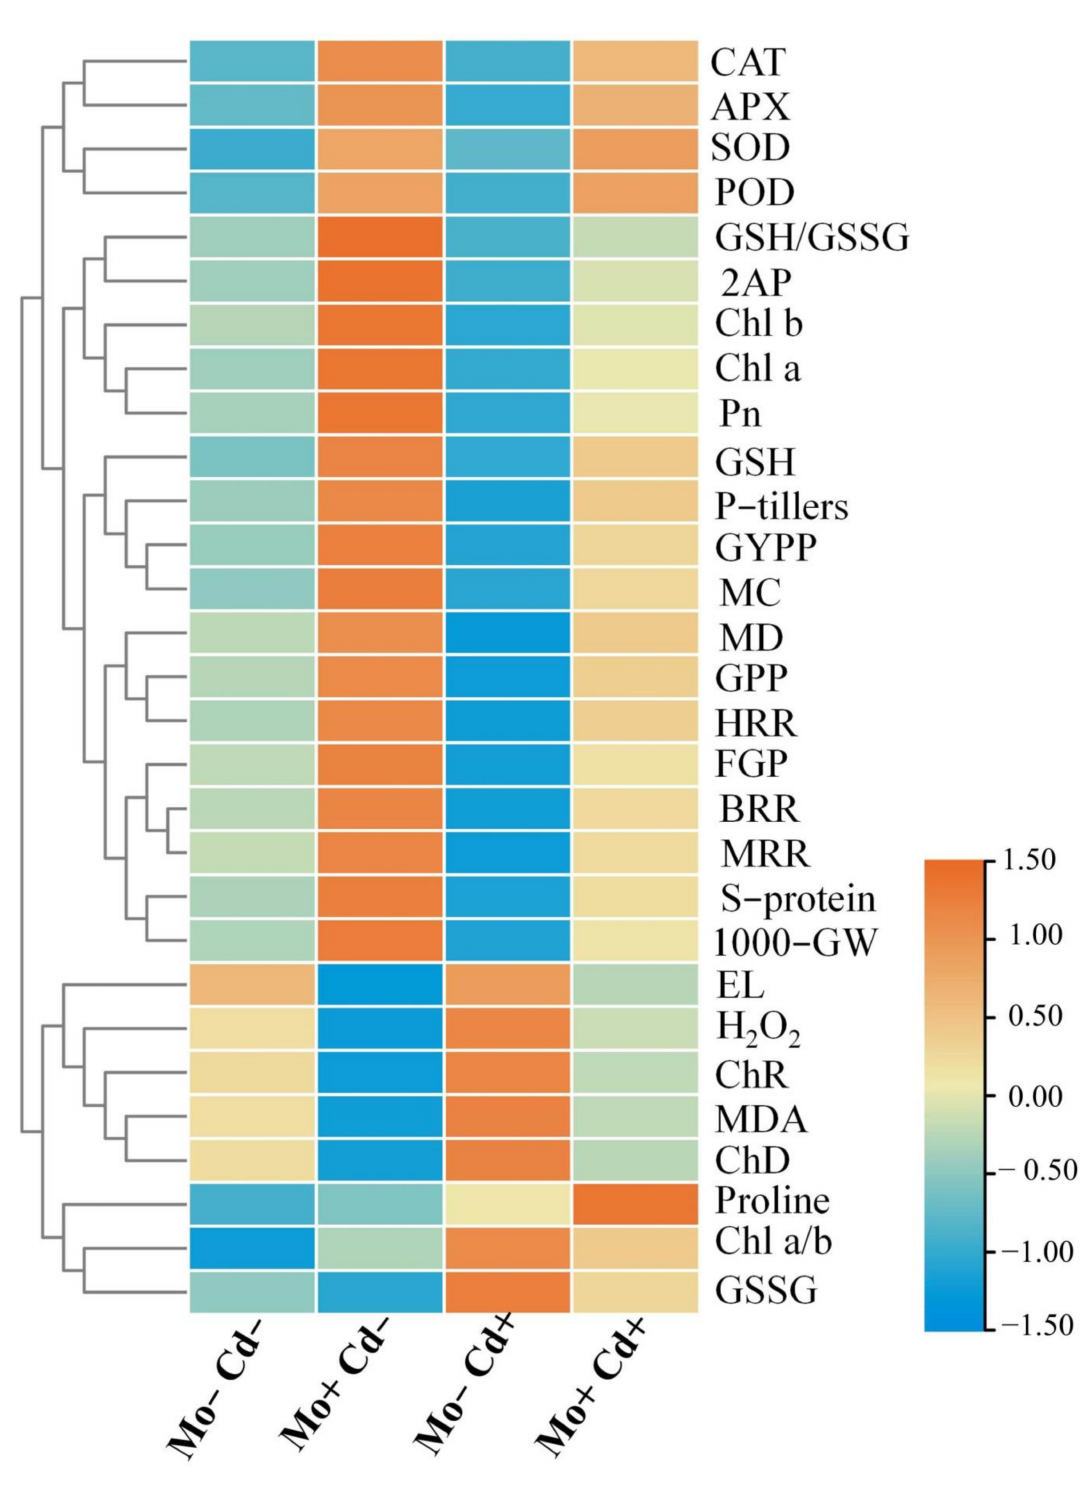
Figure 8. Heat-map reveals a hierarchical clustering analysis between different treatments and studied parameters of aromatic rice plants. Abbreviated names are as follows: 2AP (2-acetyl-1-pyrroline), SOD (superoxide dismutase activity), POD (peroxide activity), CAT (catalase activity), APX (ascorbate peroxidase activity), Chl a (chlorophyll a), Chl b (chlorophyll b), Pn (photosynthetic rate), GSH (reduced glutathione), GSSG (oxidized glutathione), P-tillers (productive tillers), HRR (head rice rate), MRR (milled rice rate), FGP (filled grain percentage), BRR (brown rice rate), S-protein (soluble protein), 1000-GW (1000-grain weight), EL (electrolyte leakage), H 2 O 2 (hydrogen peroxide), ChR (chalkiness rate), ChD (chalkiness degree), MDA (malondialdehyde contents), MC (moisture content), MD (milling degree), GPP (grains per panicle), GYPP (grain yield per